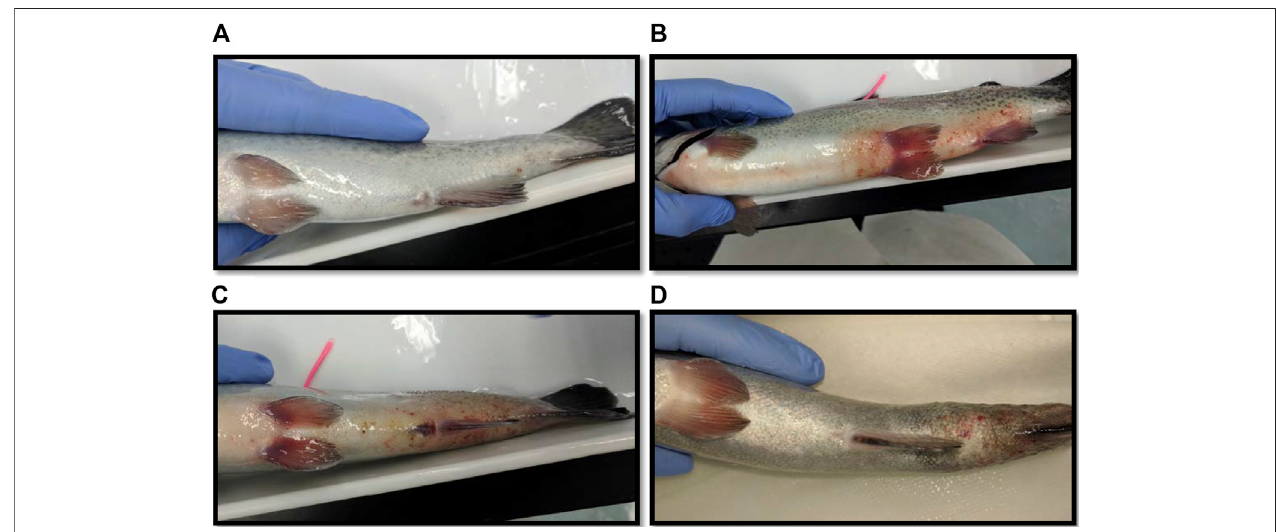
FIGURE 4 | (A) Photograph of a fi sh considered fully healed after sampling blood in the laboratory. (B) A fi sh with a red and swollen abdomen. (C) A fi sh with a red and swollen tail. (D) A fi sh whose tail has become necrotic after blood sampling.